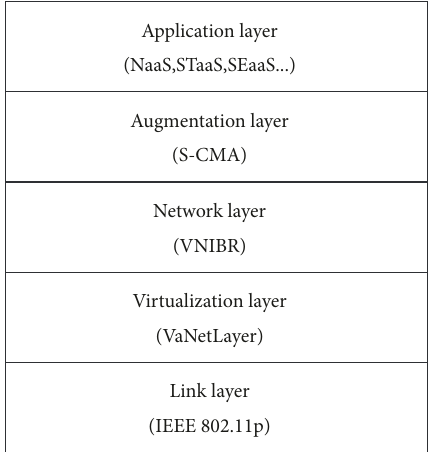
Figure 1: Protocol stack of our